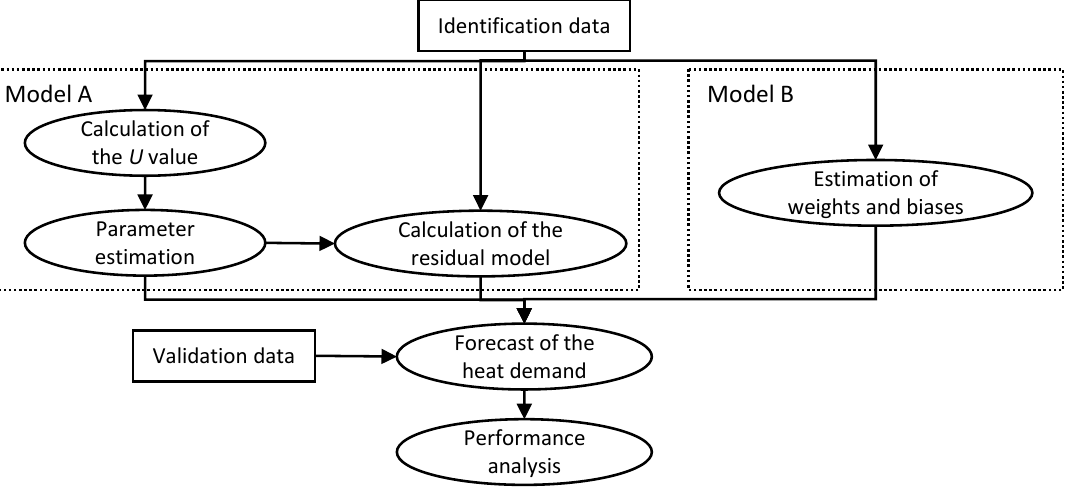
Figure 3. The identification and validation procedure for the heat demand forecast models.